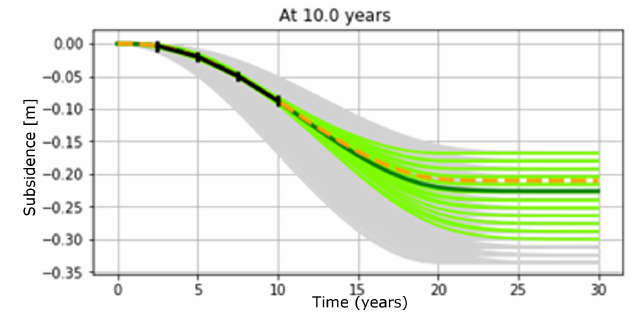
Figure 8. As the middle panel of Fig. 7, but now for more frequent measurements, taken every 2.5